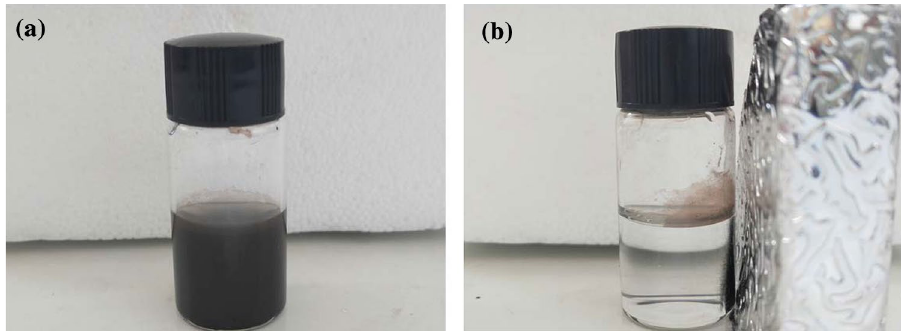
Figure 9. Photo of the 6O-MWCNTs@Fe 3 O 4 separation and redispersion process. ( a ) without an external magnetic field and ( b ) with an external magnetic field.